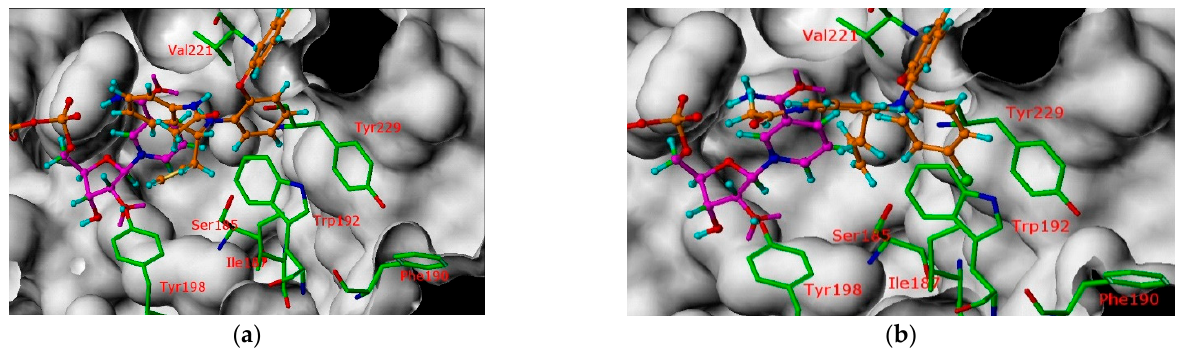
Figure 12. ( a ) The inactive enantiomer A ( 31 , R -(-)-) and ( b ) the active enantiomer B ( 32 , S -(+)-) docked into the 17 β HSD3 homology model.